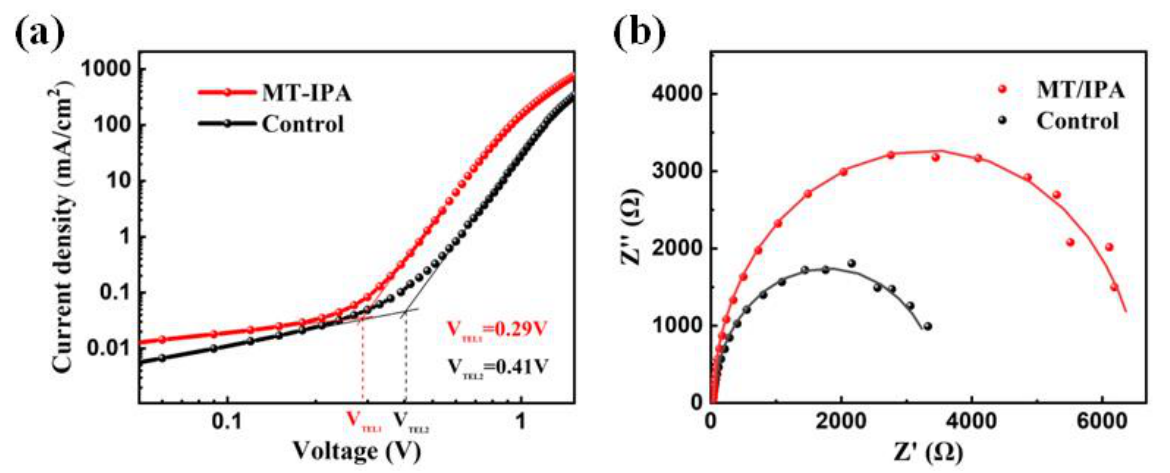
Figure 4. ( a ) SCLC curves of the untreated devices and MT/IPA-treated devices. ( b ) EIS of the untreated devices and MT/IPA-treated devices.